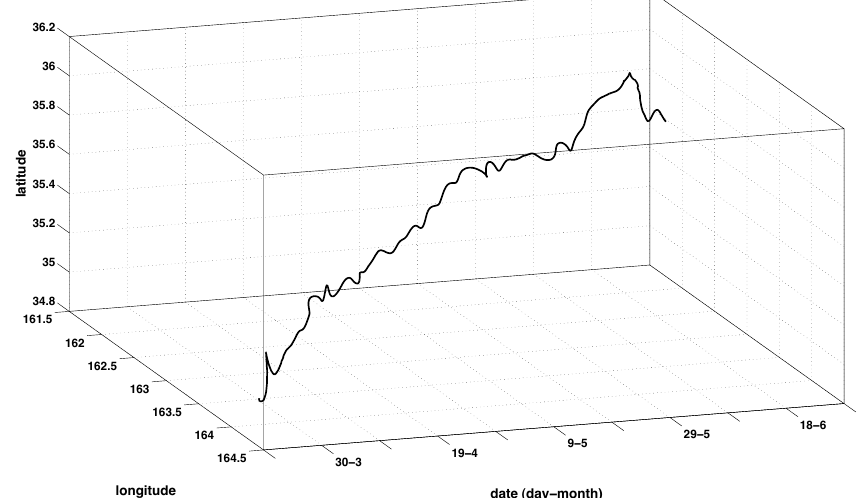
Fig. 15. Path of limit coordinates for DHT E .